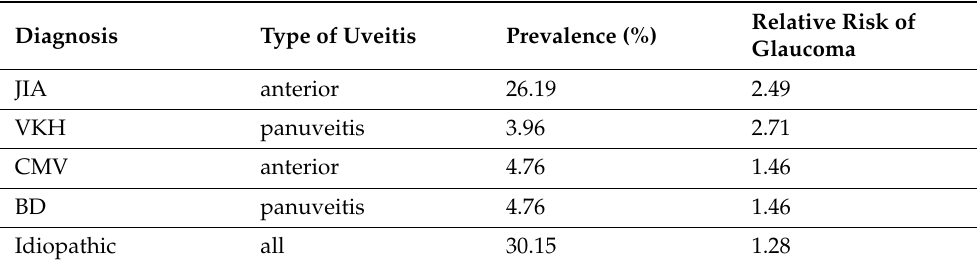
Table 1. Type of uveitis and prevalence of pediatric uveitis with the corresponding relative risk (RR) of UG. JIA: Juvenile Idiopathic Arthritis; VKH: Vogt–Koyanagi–Harada; CMV: Cytomegalovirus; BD: Behçet’s